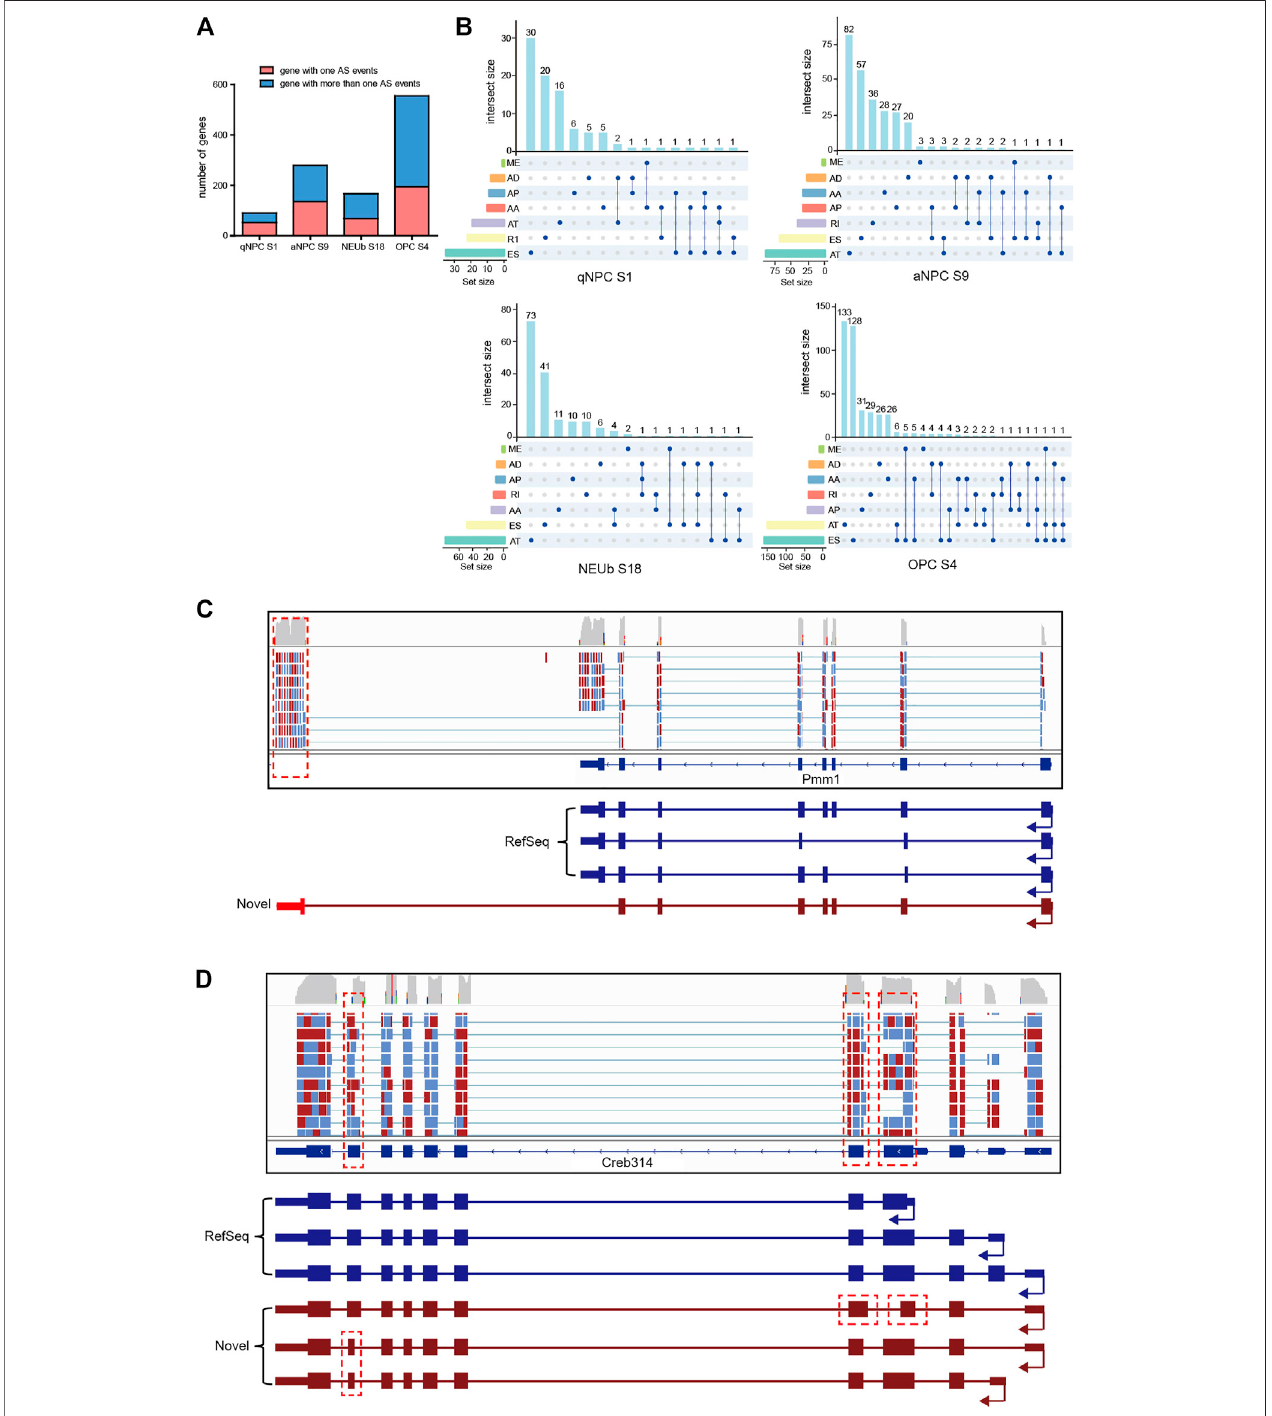
FIGURE 4 | Isoform number analysis for a de fi nite gene in individual cells. (A) Number of genes with one AS event and more than one AS event in four selected single cellsfor isoform number analysis. (B) Onegene may incur more than one type ofalternativesplicing events inasingle cell. (C) In anindividualoligodendrocyte, the Pmm1geneexpressedtwospliceisoforms. (D) Inanindividualactivatedstemcell,theCreb3l4geneexpressedtwospliceisoforms.IsoformsinRefSeqareinblue,novel isoforms detected in this work are in brown, and the locations of novel alternative splicing events are indicated in red.